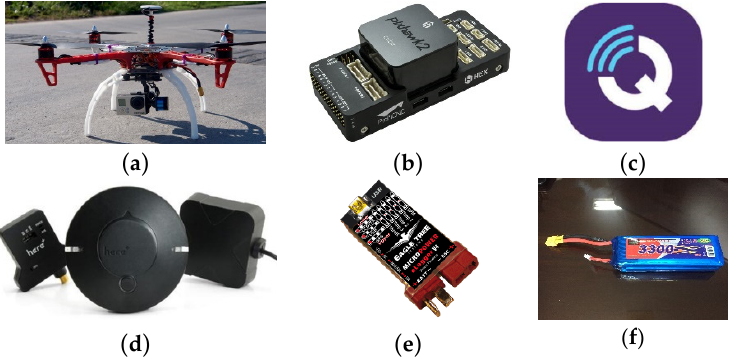
Figure 10. Flight experiment parts: ( a ) F450 quadrotor, ( b ) Pixhawk 2.1, ( c ) QGroundControl (QGC), ( d ) Pixhawk 2.1 Here + RTK, ( e ) eLogger V4, and ( f ) 4s 3300-mAh battery pack.